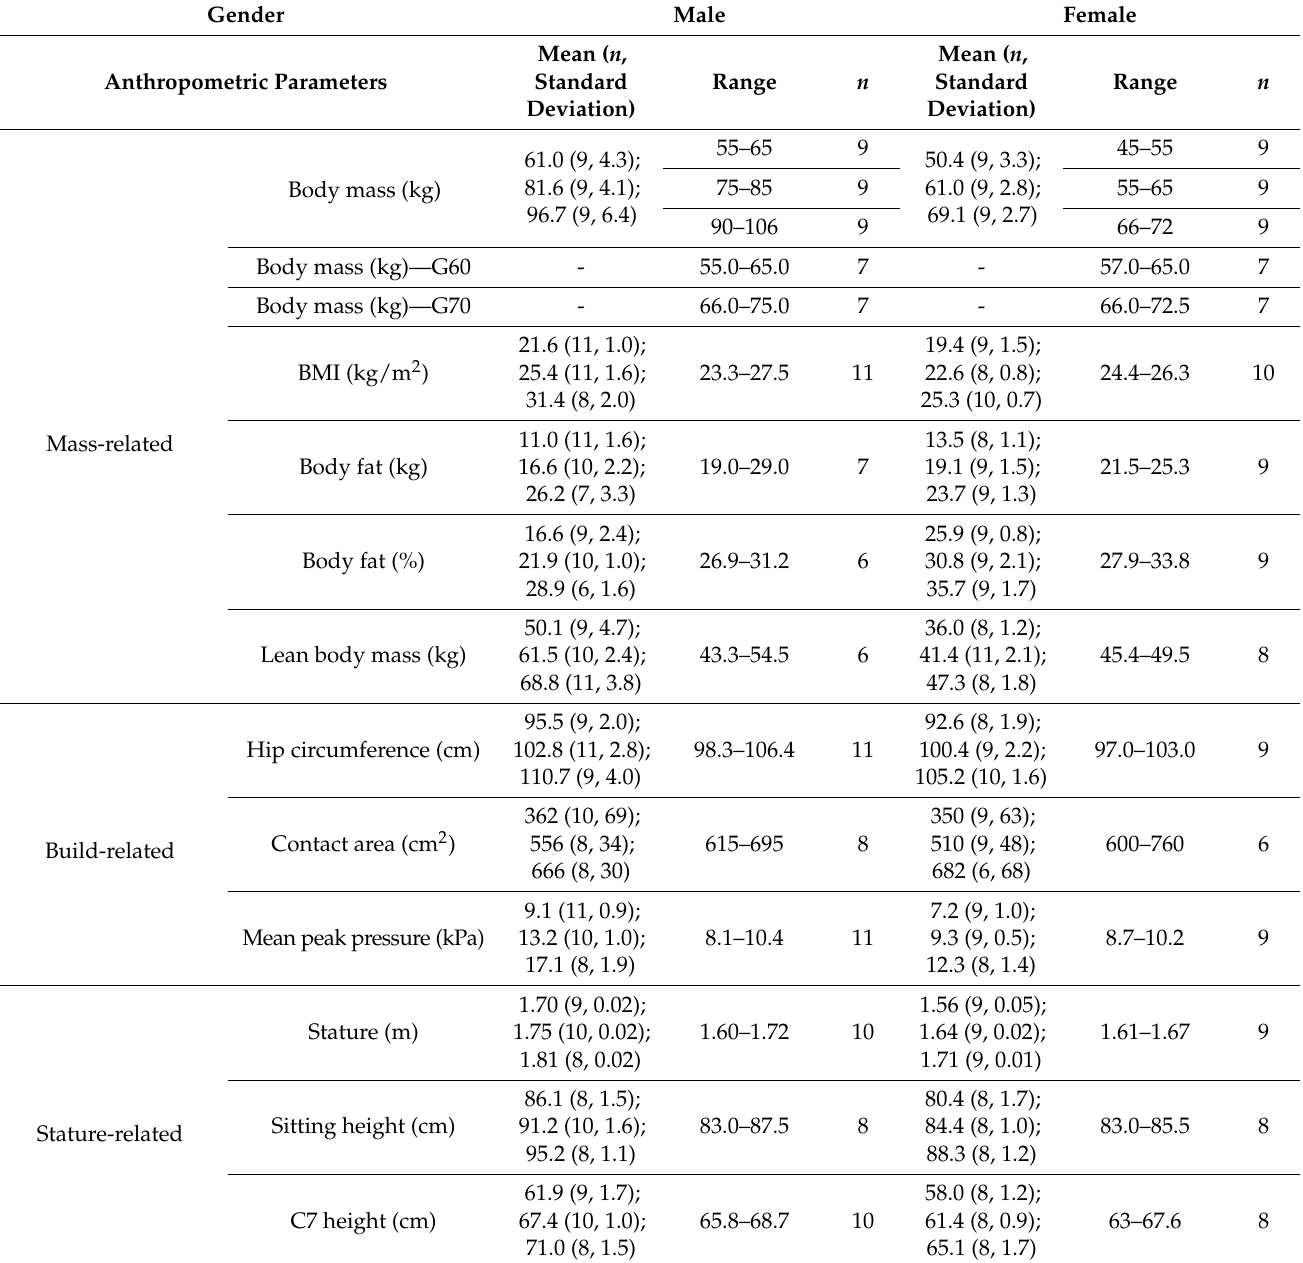
Table 2. Means (standard deviations) of selected anthropometric dimensions of males and females subsets corresponding to three comparable ranges of body mass and anthropometric